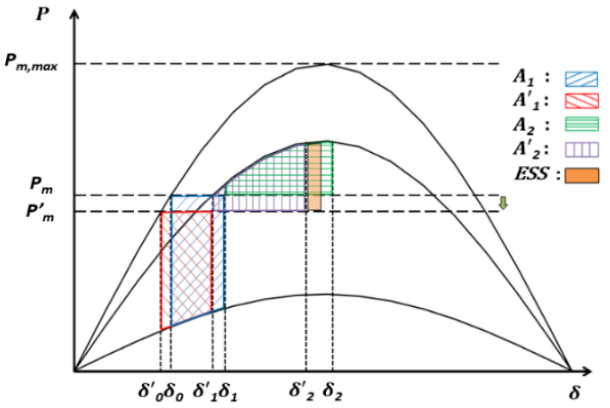
Figure 2. EAC with the generation curtailment and BESS .